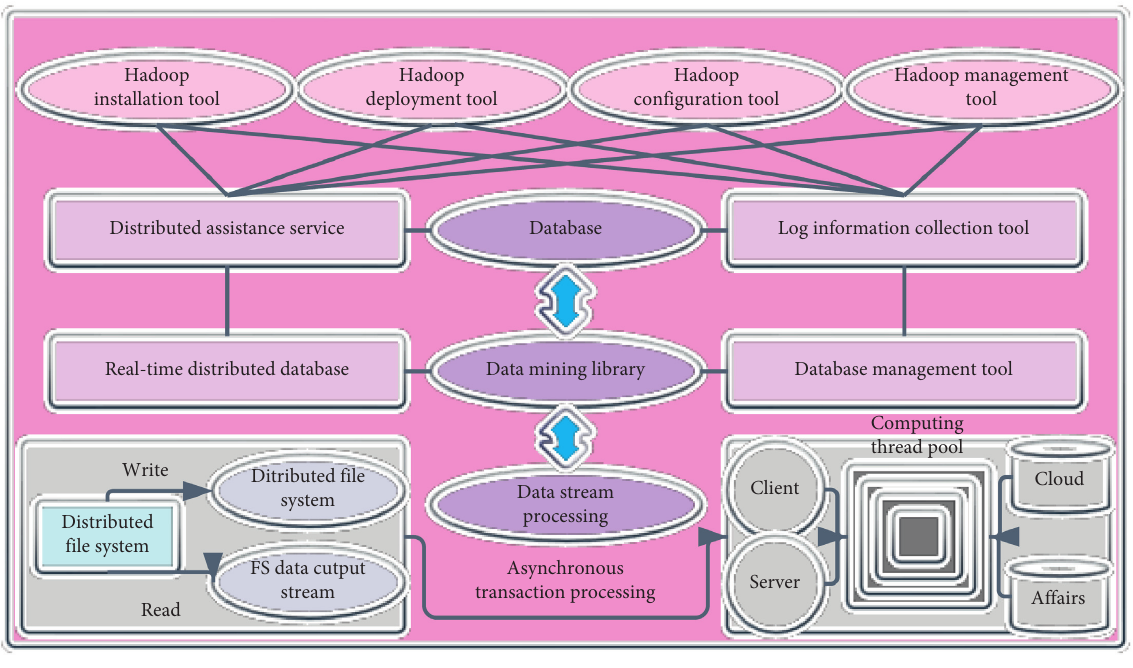
Figure 1: Core components of